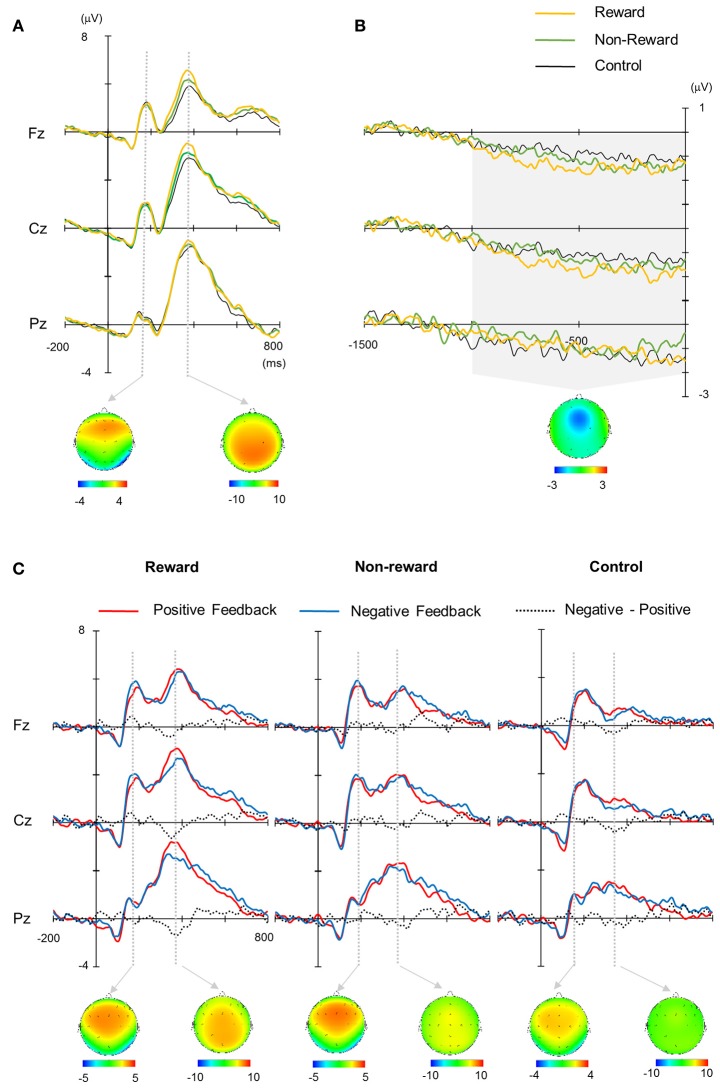
(A) Grand average waveforms for target stimuli. (B) Stimulus preceding negativity (SPN). (C) Grand average waveforms for feedback stimuli. Each topography was obtained across conditions (mean average of the reward, non-reward, and control conditions for target stimuli (A), positive and negative conditions for feedback stimuli (C) at the peak of the grand average waveform. The latency for depicting each topography was 188 ms for target P2, 372 ms for target P3, 188 ms for feedback P2, and 364 ms for feedback P3. The topography of SPN was made from the mean amplitude between 1,000 ms pre-stimulus and stimulus onset (B).